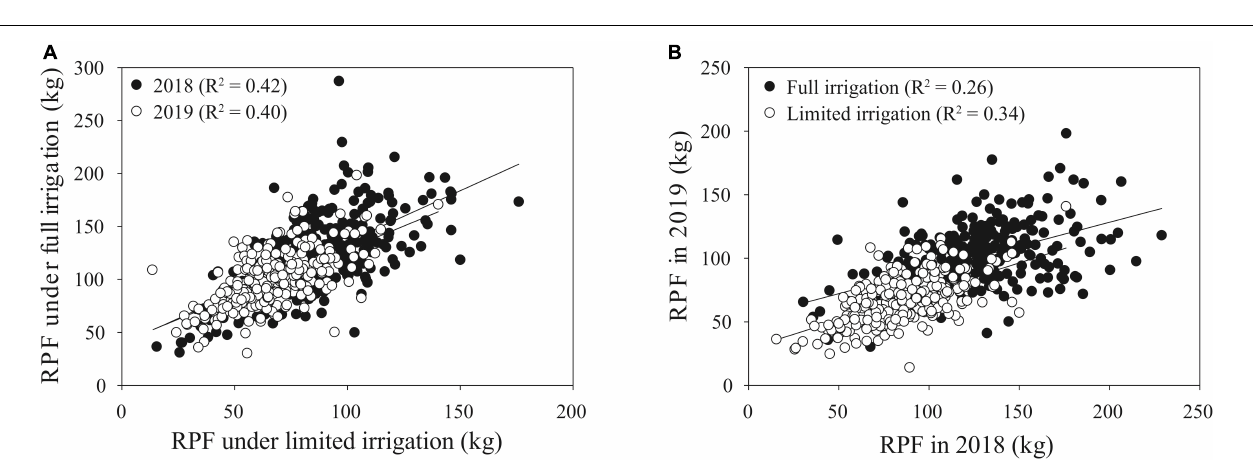
FIGURE 5 | Genotypic correlation for RPF of lines among environments. (A) Correlations between treatments, for 2018 R 2 = 0.42 and for 2019 R 2 = 0.40. (B) Correlations between years, for FI R 2 = 0.26 and for LI R 2 = 0.34. Data shown are from the post-flowering stage in 2018 and mid-flowering in